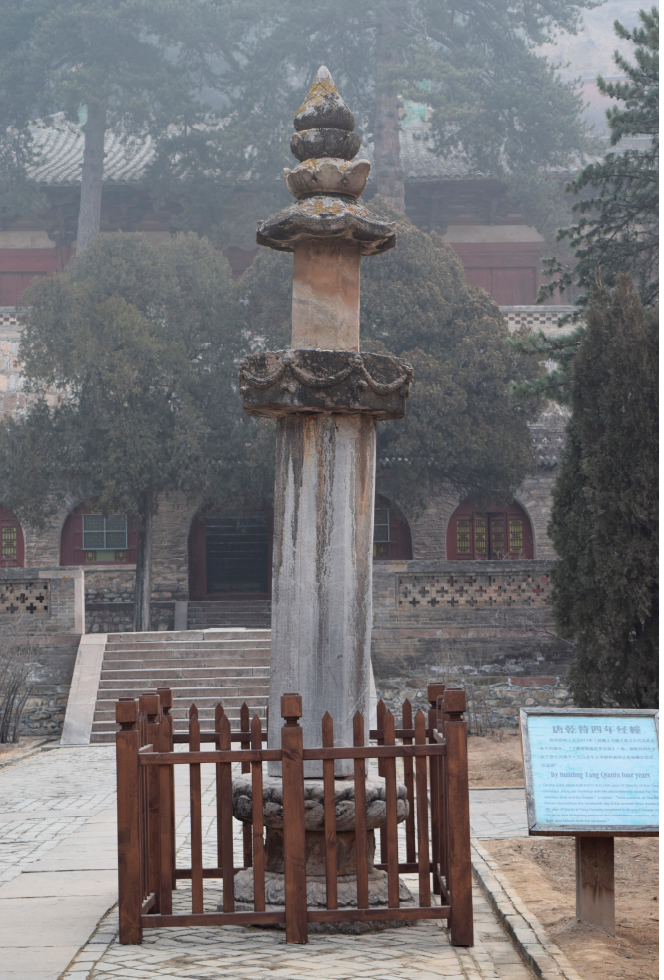
Figure 15. Two-storied incantation pillar at Foguang Monastery [©Photograph by Youn-mi Kim, 2016].